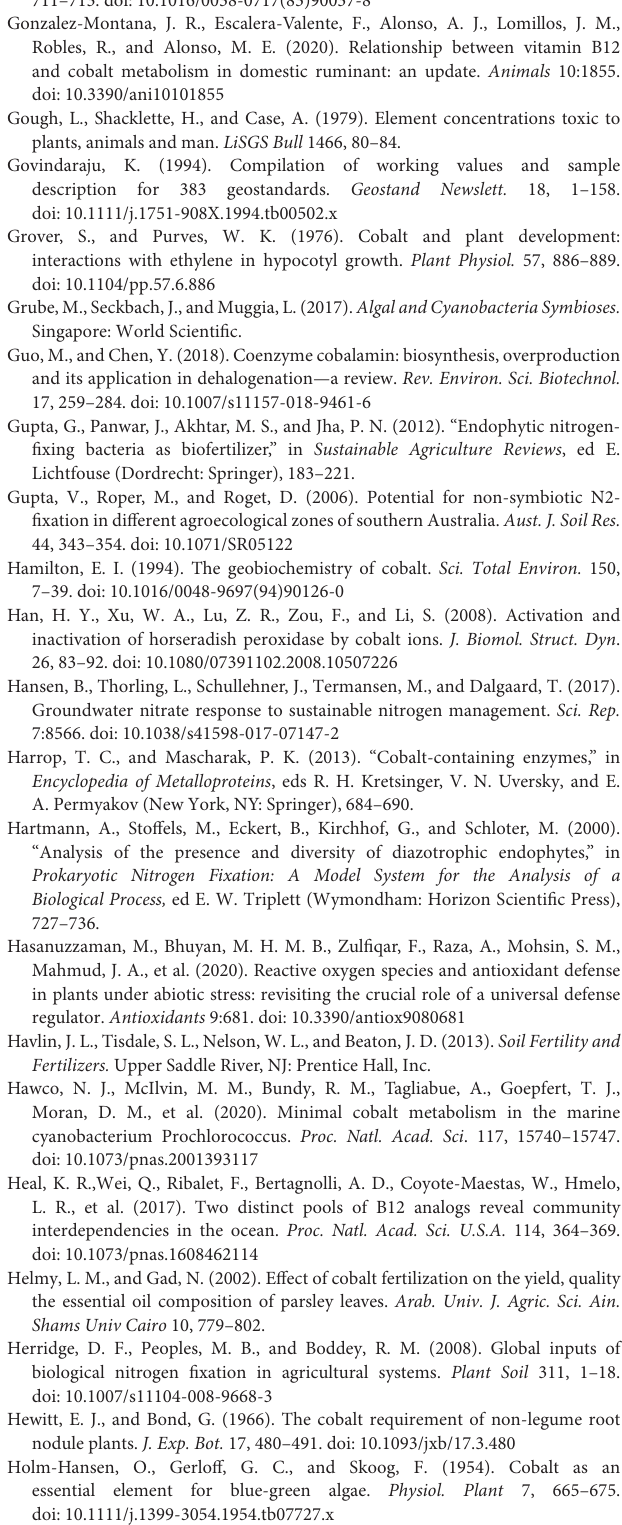
(vitamin B12) provides significant protection against salinity stress in the common bean. Rhizosphere 3, 143–149. doi: 10.1016/j.rhisph.2017.04.010